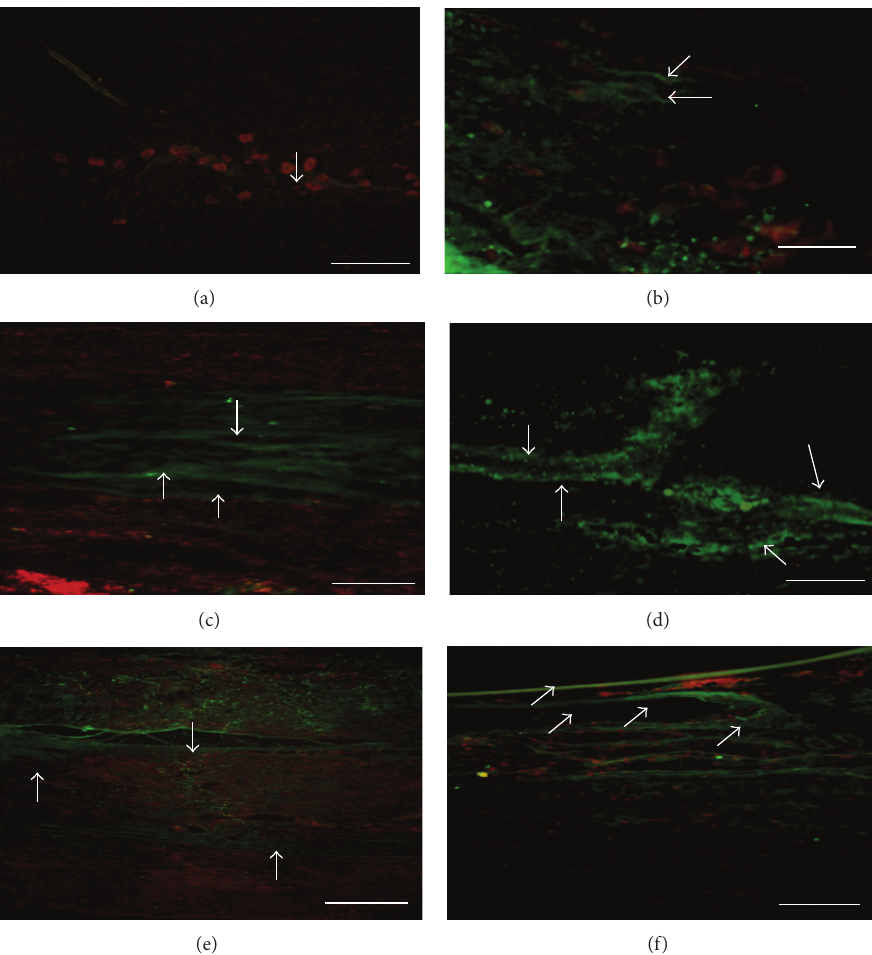
Figure 3: Photomicrography of the expression of GAP-43 in spinal cord. (a) Control group. (b) Fibrin glue group (FG). (c) PPN group, rostral zone of the SC. (d) PPN + BMSCs group, rostral zone of the SC. (e) PPN group, caudal zone of the SC. (f) PPN + BMSCs group, caudal zone of the SC. A greater quantity of GAP-43 positive fibers can be observed in panels (c) to (f) (white arrows, Alexa 488, green color), compared to panels (a) and (b). Furthermore, and easily visible, the positive fibers which were found in the PPN + BMSCs group ((e) and (f)) are thicker than those ones which were in the PPN group ((c) and (d)). All the tissue was contrasted with propidium iodide (nuclei red color). Calibration bar 20 𝜇